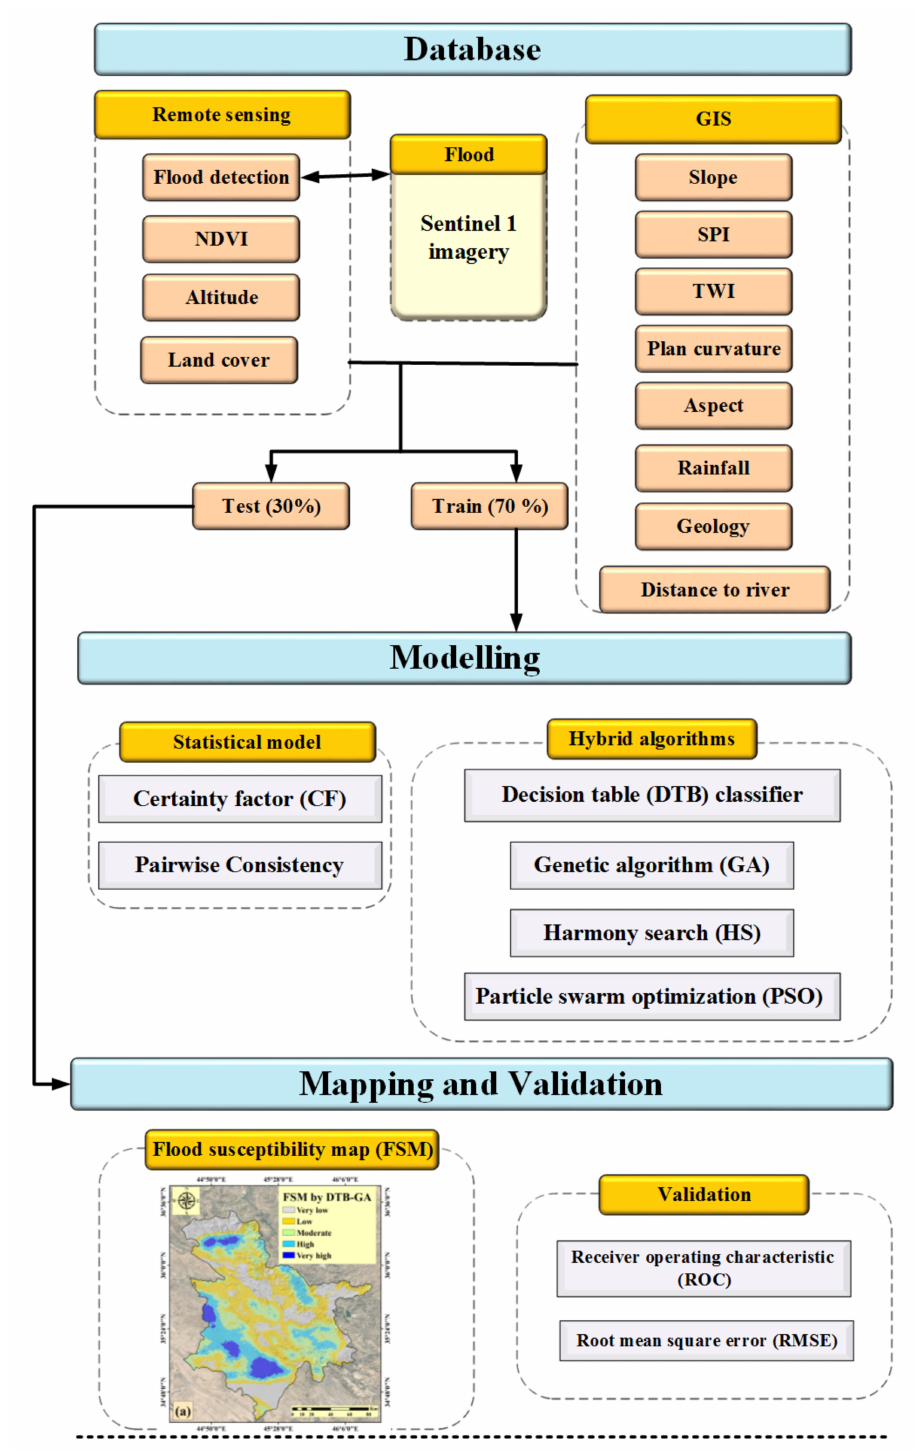
Figure 1. General steps of